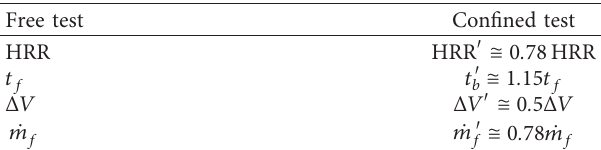
Table 8: Relations between parameters of fires in opened and confined